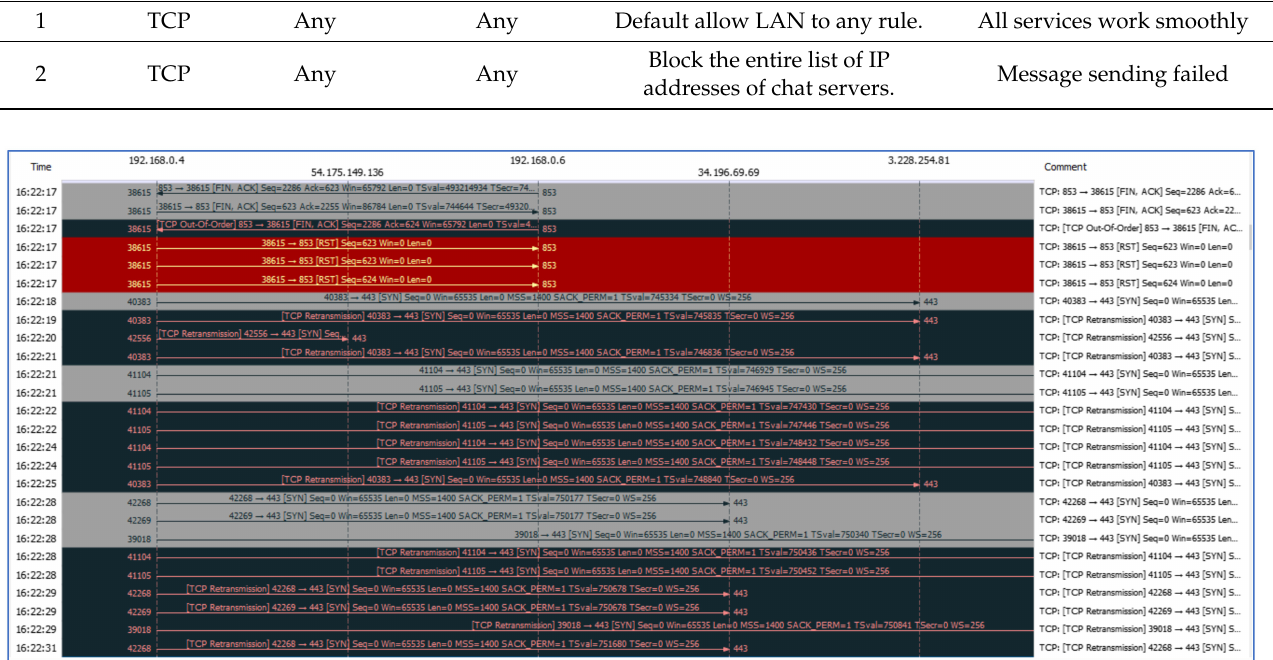
Figure 21. Traffic pattern responses from blocked